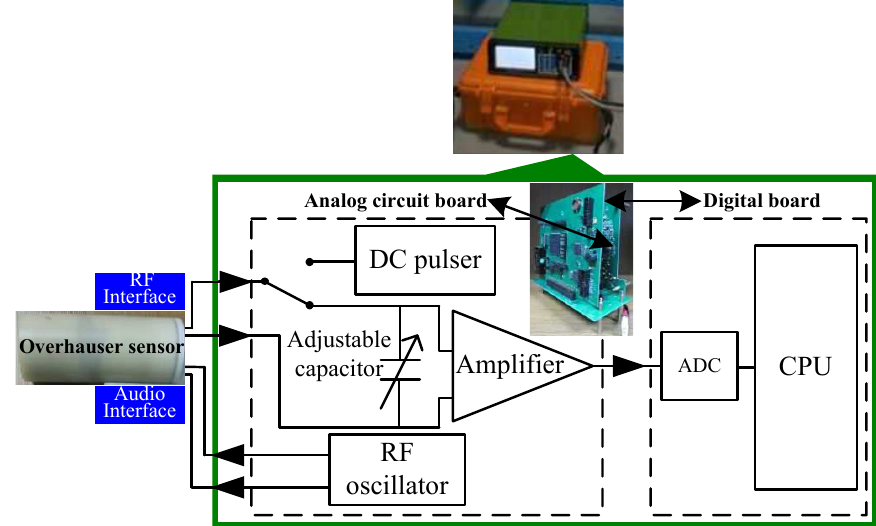
Figure 12. Block diagram of the Overhauser sensor test